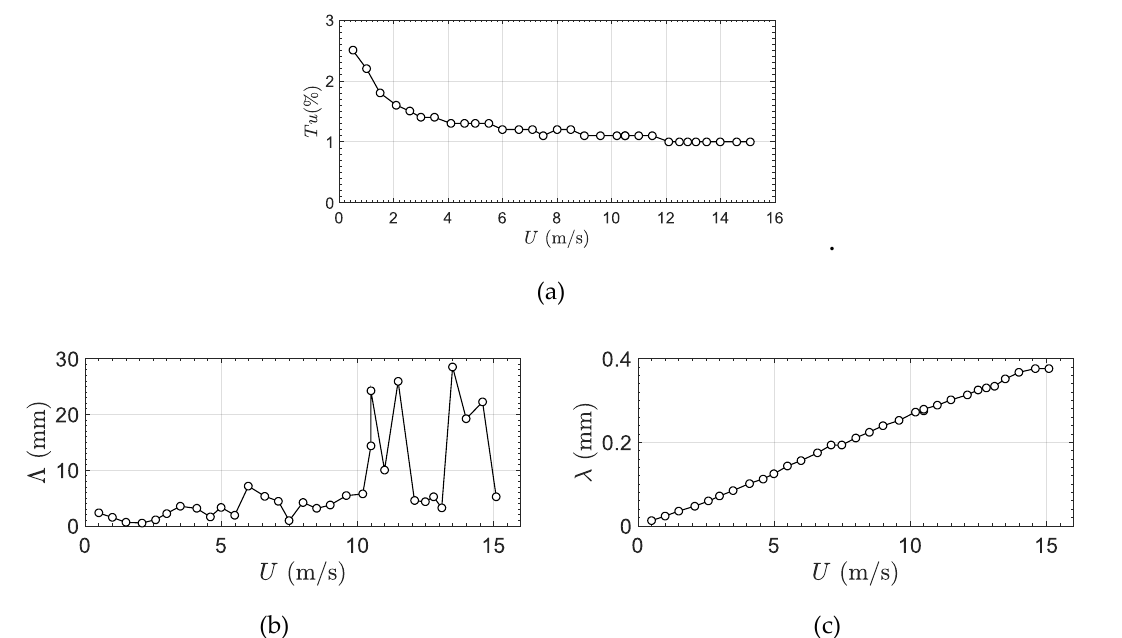
Figure 4. Preliminary characterization of the free-stream wind tunnel flow. ( a ) Streamwise turbulence intensity; ( b ) Streamwise turbulence macroscale; ( c ) Streamwise turbulence microscale.